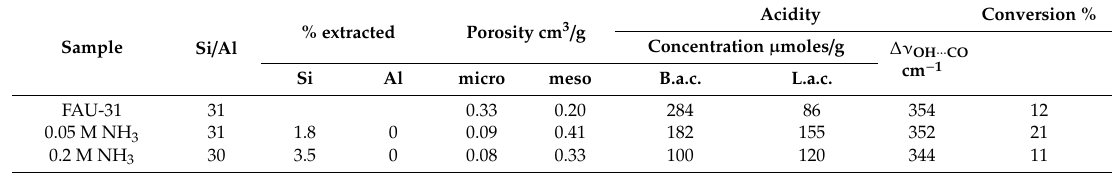
Table 4. The Si / Al values, the amounts of Si and Al extracted, N 2 porosity, concentration of Brønsted and Lewis acid sites, the acid strength of Si-OH-Al groups ( ∆ ν OH ··· CO ). Initial (after 1 min of reaction) at 393 K. The data concerning parent zeolite Y (FAU-31) and zeolites treated with 0.05 and 0.2 M solution of NH 3 at 293 K. The data were adapted (with the permission) from [66].